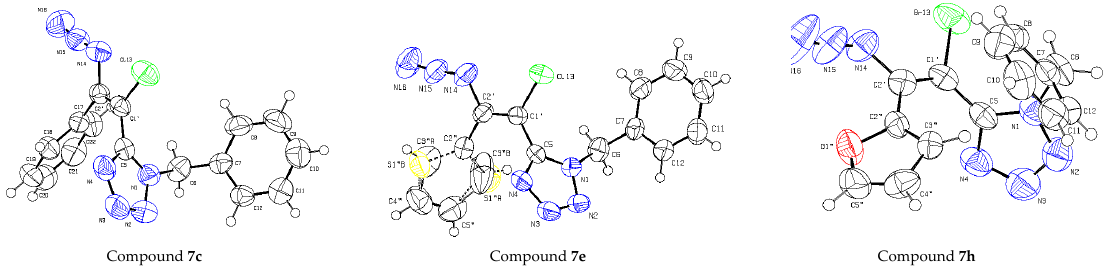
Figure 1. X-ray structures of compounds 7c , 7e and 7h .